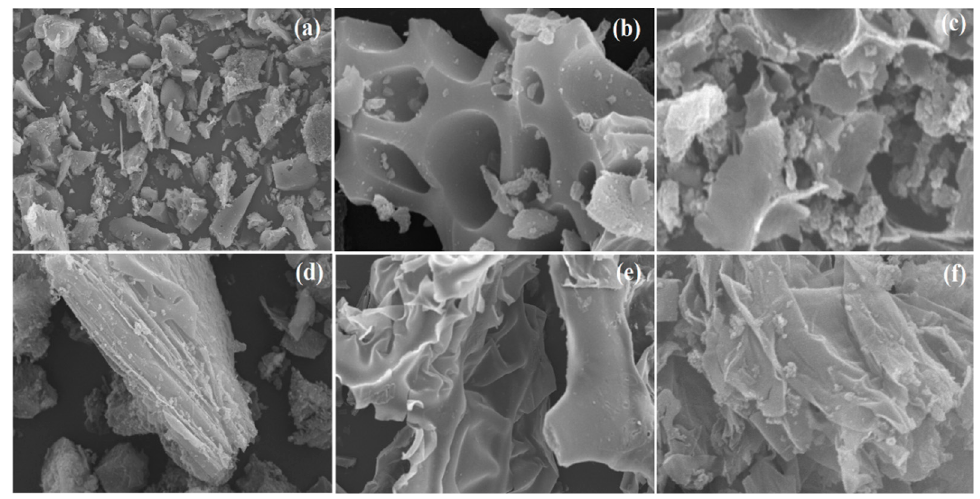
Figure 2. SEM micrographs of activated carbon olive trees ( a – c ) and Lantana camara ( d – f ).